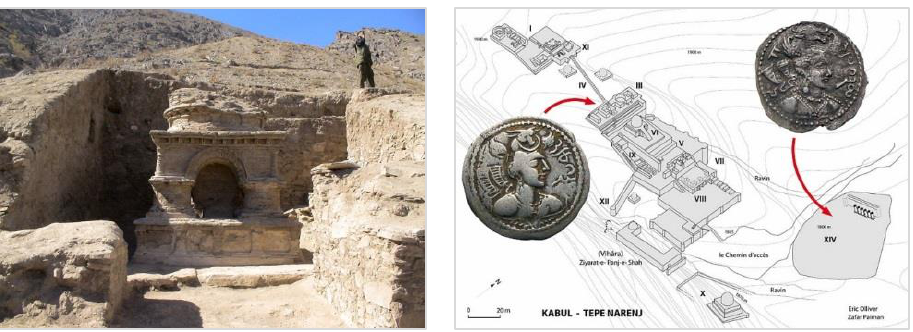
Figure 5 Illustrations showing Buddhist architectural monuments (WMF,